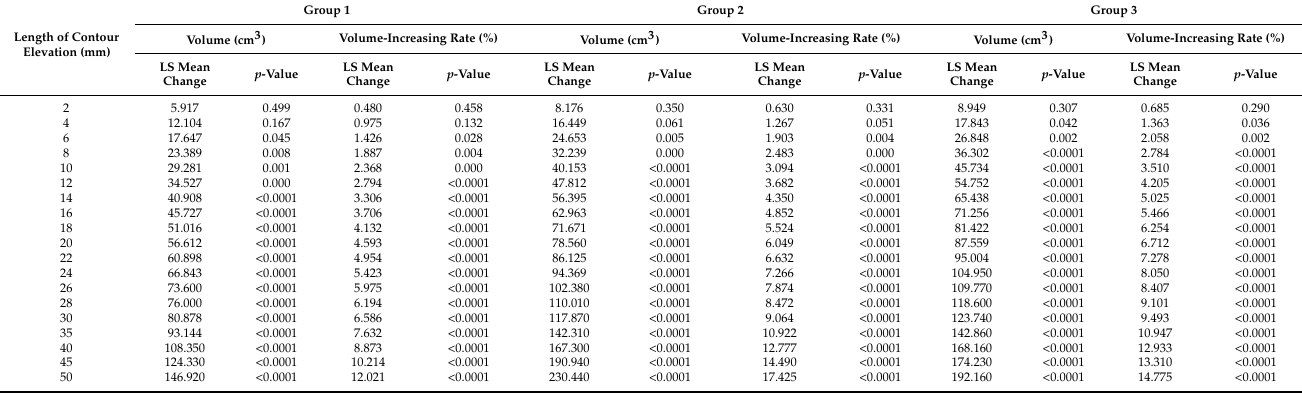
Table 6. Comparison of the effects of contour elevation on volume expansion among Groups 1–3